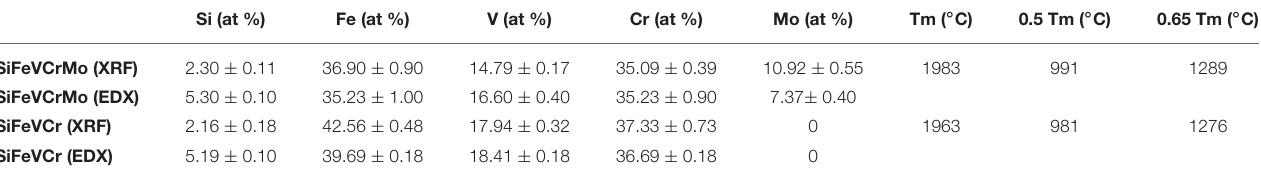
TABLE 1 | Measured alloy compositions from XRF and EDX, and melting and annealing temperatures calculated using the rule of mixtures and XRF data. Si (at %)